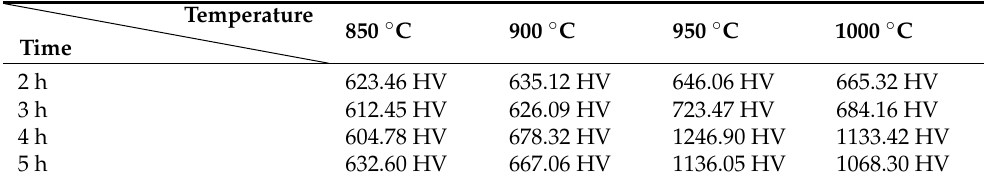
Table 4. Hardness of penetration layer at different temperature and time (40 µ m from the surface of the infiltration layer).